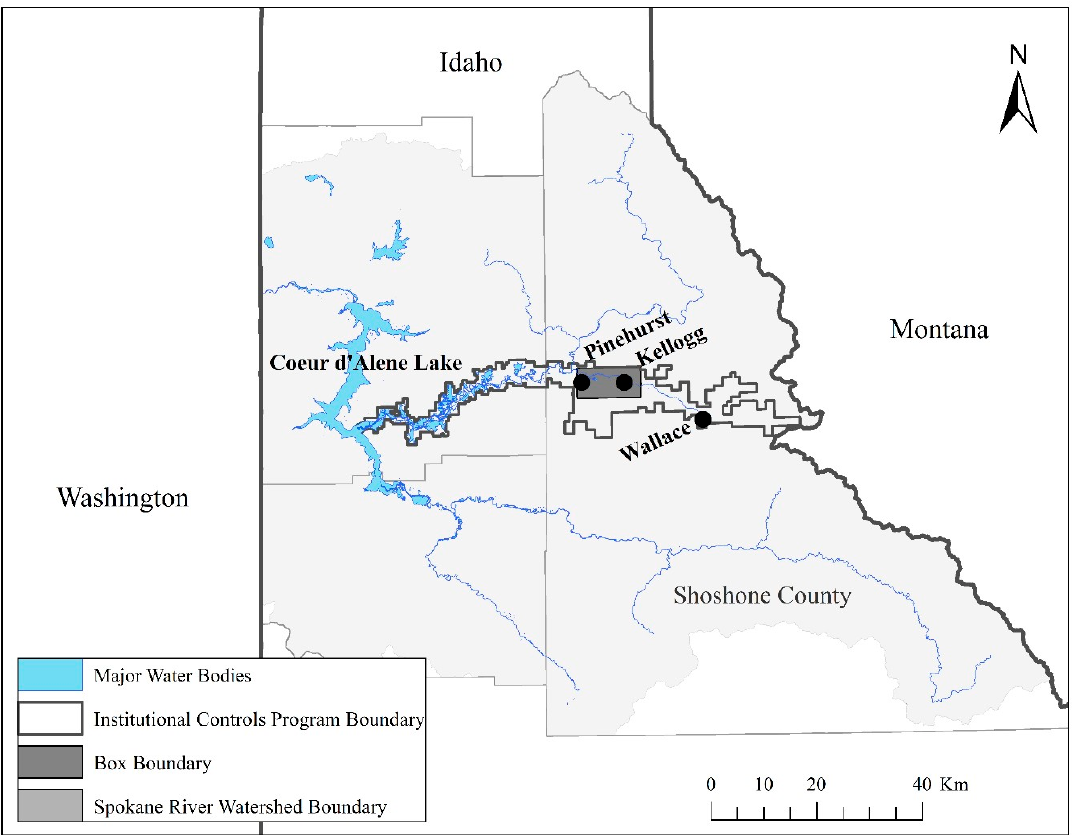
Figure 1. Communities of Kellogg, Pinehurst, and Wallace. The dark gray rectangle incorporating Pinehurst and Kellogg represents the 54 km 2 area known as “the Box”—the area of the original Bunker Hill Superfund Site that included a smelter and other processing facilities. The Institutional Controls Program Boundary includes the expanded Superfund site that includes 394 km 2 of floodplains and wetlands. Image produce in Esri ArcGIS 10.8 (Esri, Redlands, CA, USA). Data sources: [47,48].